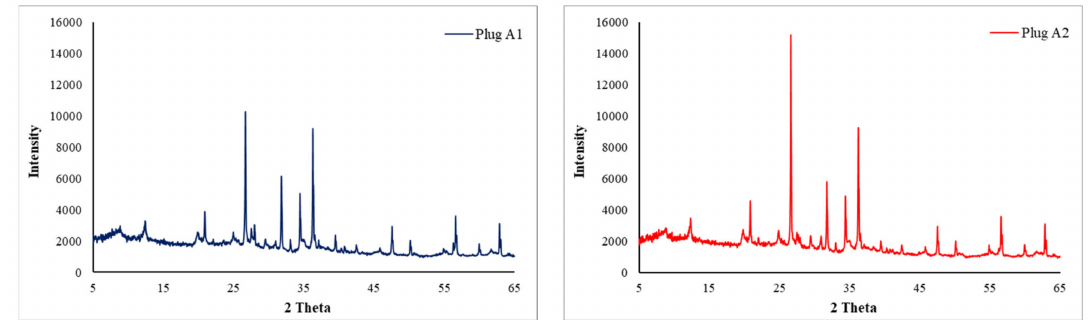
Figure 5. Results of XRD analysis on the powdered A1 (left) and A2 (right) rock samples.